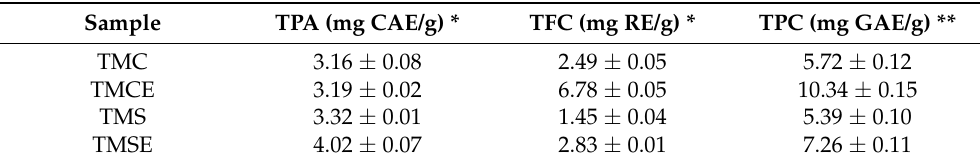
Table 1. Results obtained for the quantification of TPA, TFC, and TPC by HPLC-DAD * and spec- trophotometrical ** methods.